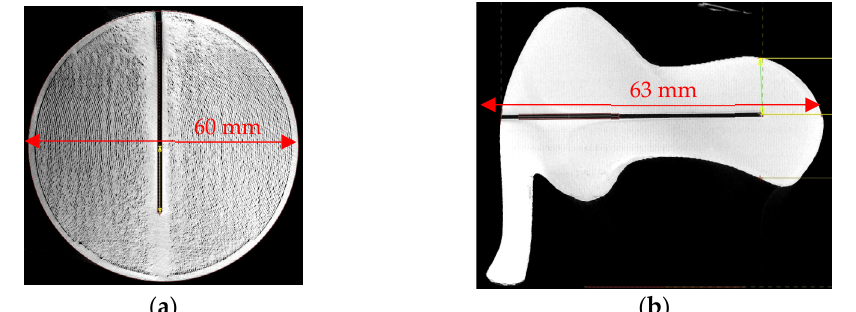
Figure 6. Computed tomographic scan of drilled holes inside the sphere ( a ) and elephant ( b ).